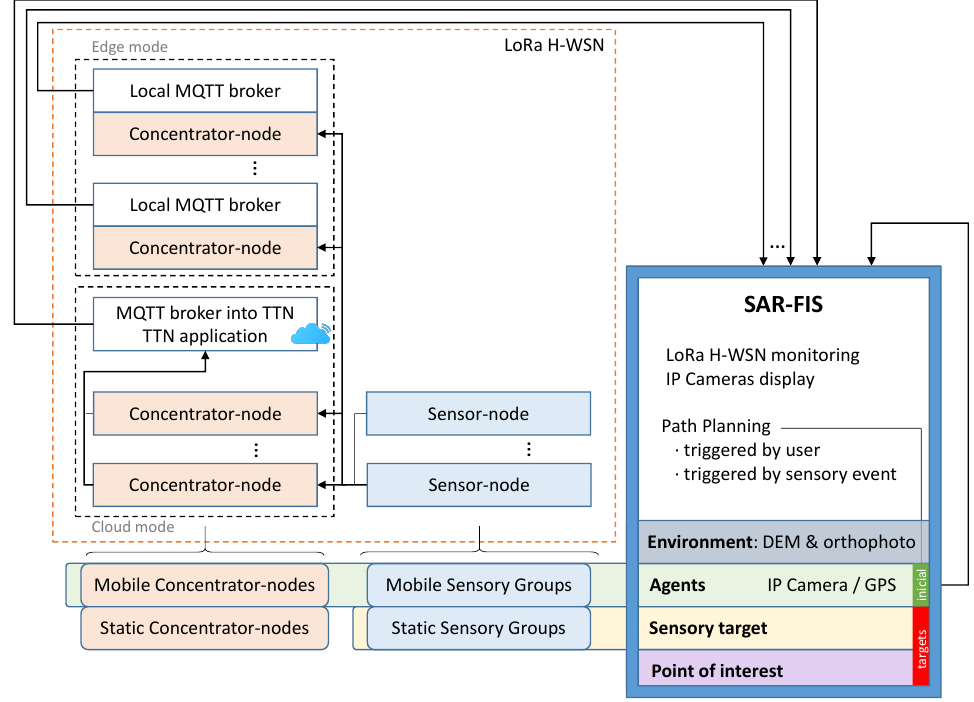
Figure 4. Integration of the LoRa H-WSN with a path planner in SAR-FIS. SAR-FIS subscribes to the topics associated with the different MQTT brokers, hosted in local edges or in the cloud, to receive the data coming from LoRa H-WSN.